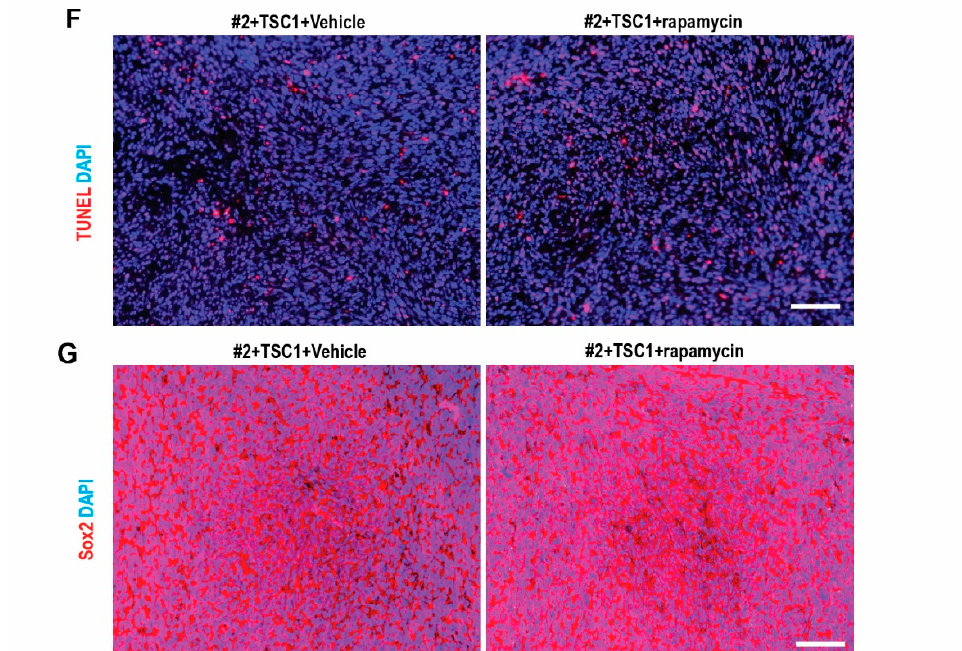
Figure 6. Re-expressing human TSC1 in Ast #2 cells and tumor. ( A ) Lysates extracted from Ast #1, Ast #2 infected with lentiviral vector or lentiviral hTSC1 were analyzed by Western blot using antibodies against TSC1, pS6RP, and total S6RP as indicated. Images were representative for 3 independent experiments. ( B ) Mean ± S.E. of cell number from Ast #1, Ast #2, Ast #2 + hTSC1 treated with vehicle or Rapamycin for 5 days in culture are shown. Experiments were repeated 6 times. ( C ) Mean ± S.E. of the tumor weight from Ast #2 and Ast #2 + hTSC1 treated with vehicle or Rapamycin for 2 weeks are shown. n = 5–6. ( D – G ) Immunofluorescent staining of pS6RP ( D ), Ki67 ( E ), TUNEL ( F ), Sox2 ( G ), and DAPI in tumors from Ast #2 + hTSC1 treated with vehicle or Rapamycin for 2 weeks. Two-way ANOVA and Tukey post hoc tests were used for statistic tests. ns: no significance; * p < 0.05, ** p < 0.01, *** p < 0.001. Bar = 50 µ